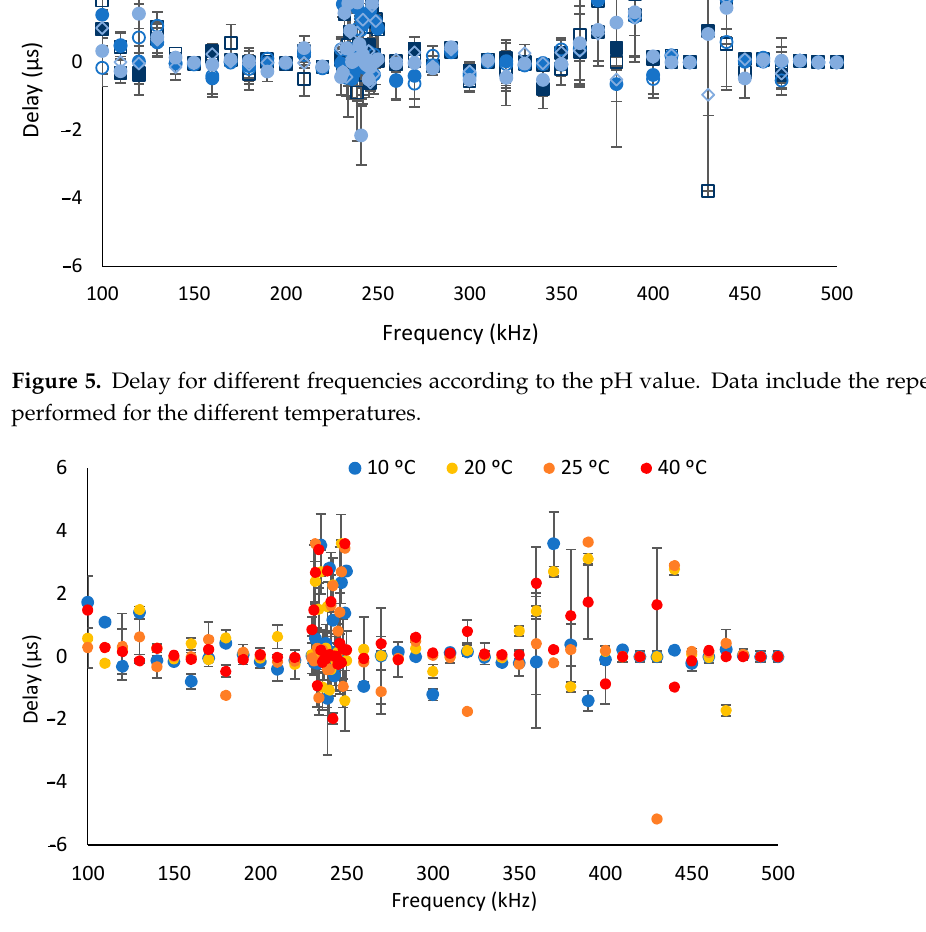
Figure 6. Delay for different frequencies according to the pH value. Data include the repetitions performed for the different pH values.